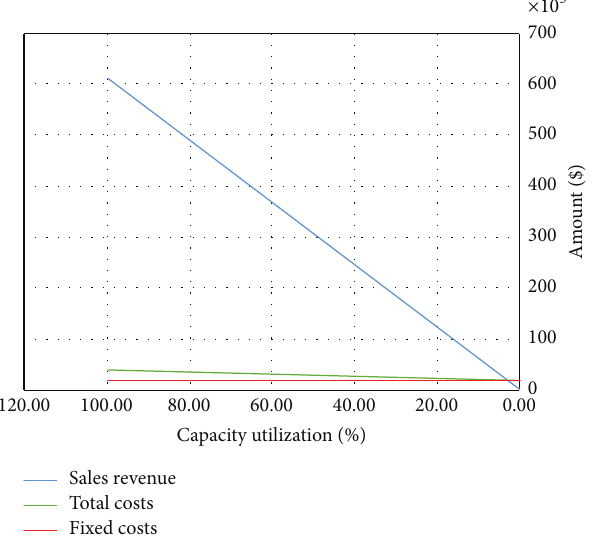
Figure 3: Break-even analysis for Model #1.